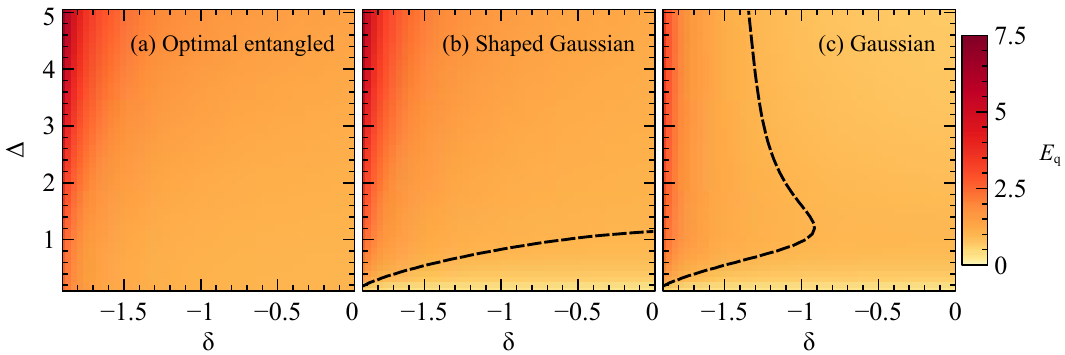
Figure 6: Comparison of the quantum enhancement E , with respect to the optimal q separable pulses (37), achievable (a) via the optimal entangled two-photon wave function (32), (b) by optimal shaping (65) of a realistic pulse (62) with Gaussian single-photon distribution (68), and (c) by an unshaped realistic pulse (62), with Gaus- sian profile (68). In all panels we explore the ranges ∆ ∈ [ 0.1;5 ] and δ ∈ [ − 1.9;0 ] . In panels (b) and (c) the width of the Gaussian distribution is set to σ = ∆ for each pair ( δ , ∆ ) , to enable the comparison with the optimal separable pulses. The dashed line in (b) and (c) traces the pairs ( δ , ∆ ) where the realistic two-photon wave = 1, i.e. it functions [ shaped by (65) and unoptimized (62), respectively ] yield E q demarcates the region (above / to the left of the dashed line) where the optimized states can outperform optimal separable states. Panel (a) reproduces the numerical results of [ 40 ]